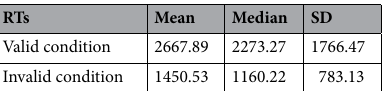
Table 1. Descriptive data of RT of the